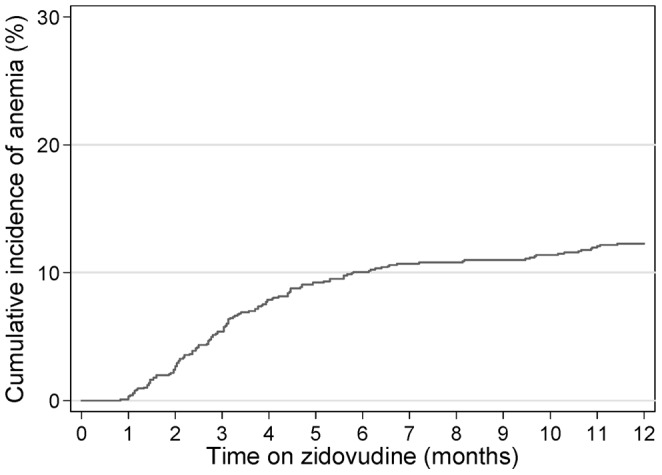
Cumulative incidence of AZT-related anemia requiring AZT-discontinuation over 1 year of AZT use.